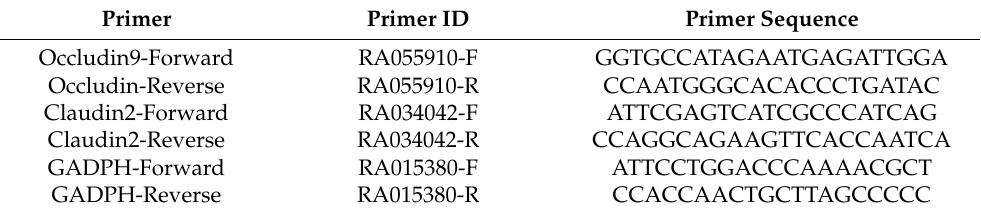
Table 2. List of forward and reverse primers used in real-time